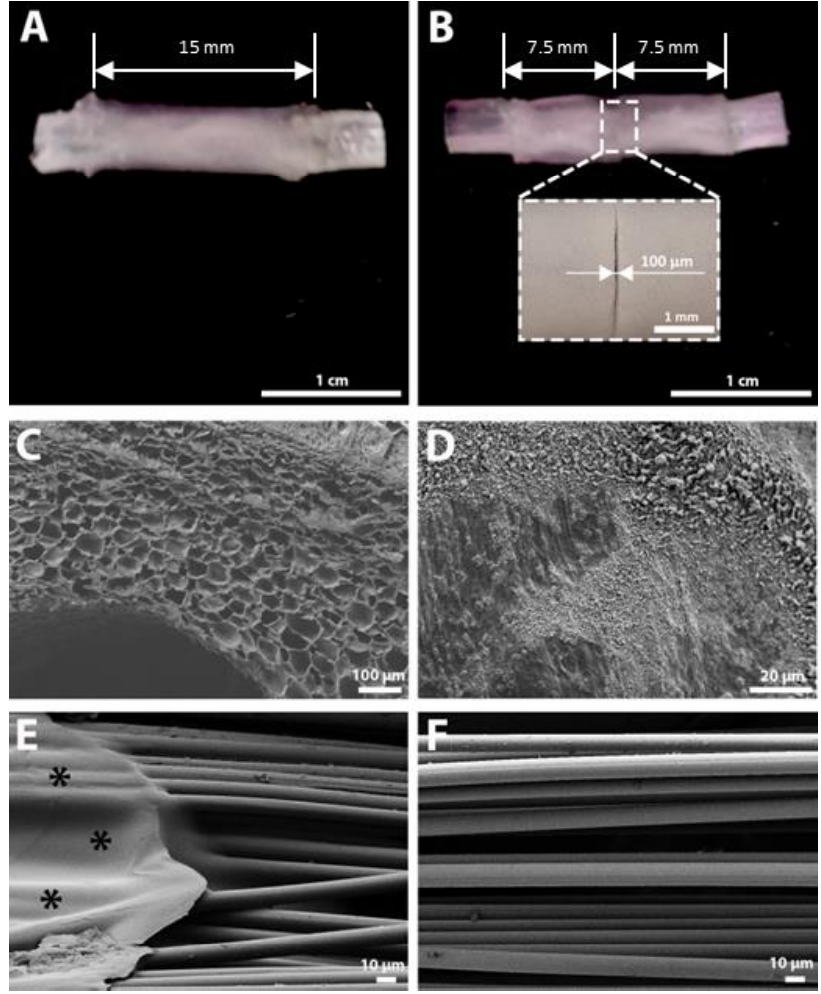
Figure 3. Macroscopic and field emission scanning electron microscope (FESEM) images of the acellular conduits. ( A ) Macroscopic image of the unimodular conduit (UMC). ( B ) Macroscopic image of the multimodular conduit (MMC) incorporating a detail of the central zone of the conduit to appreciate the gap between both HA modules. An arrow indicates the inter-module separation. ( C ) FESEM image of a cross section of the hyaluronic acid (HA) conduit showing the porous structure. ( D ) FESEM image of the HA conduit inner surface. ( E ) FESEM image of an end of the polylactic acid (PLA) microfiber bundle showing the flat ring (marked with *) that holds microfibers in position and allows the suture of the conduit to the nerve stump. ( F ) FESEM image of the PLA microfiber bundle showing the high alignment of PLA microfibers.